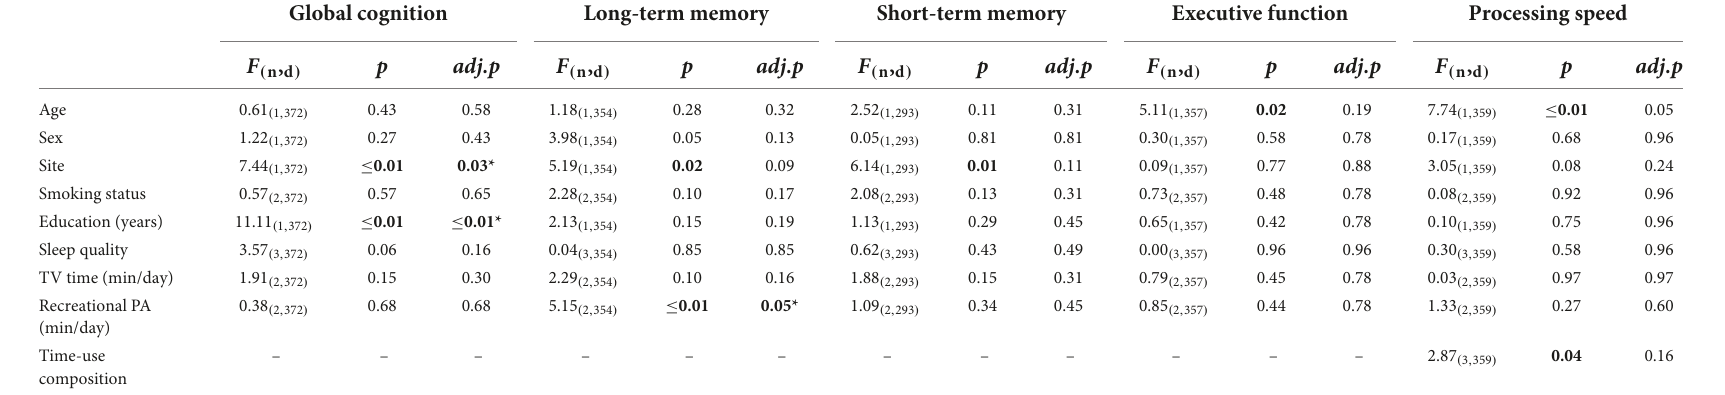
TABLE 4 Statistical output of ANOVA type II F-tests for cognitive